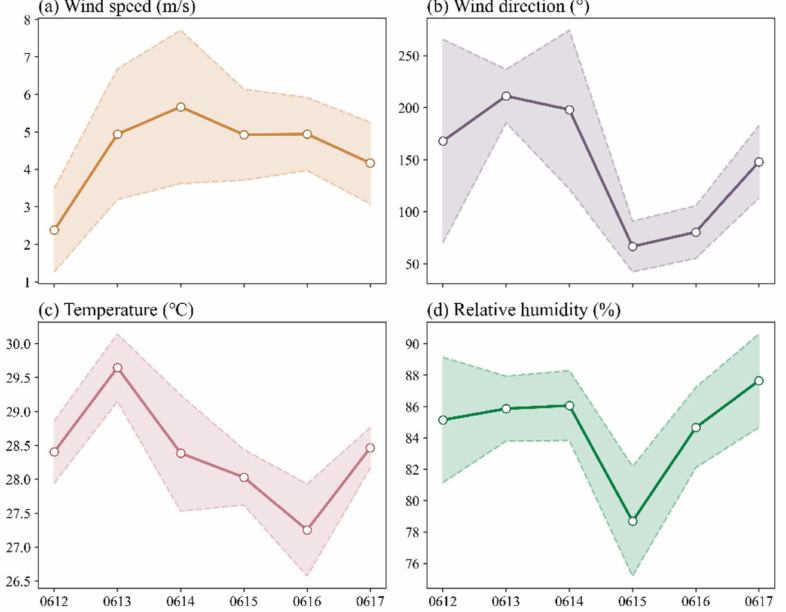
Figure 7. Daily variations in meteorological elements during the period from 12 to 17 June 2019: ( a ) wind sped (m/s); ( b ) wind direction ( ◦ ); ( c ) temperature ( ◦ C); ( d ) relative humidity (%). In addition, hollow dots represent the average values, while the shadows indicate the standard